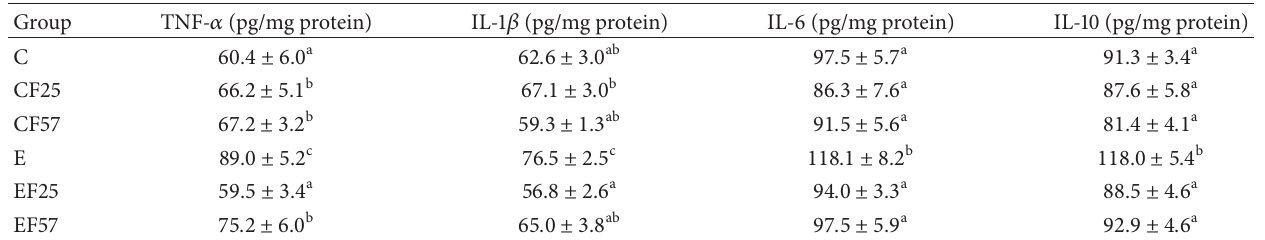
Table 6: Effects of fish oil on hepatic tumor necrosis factor- (TNF-) 𝛼 , interleukin- (IL-) 1 𝛽 , IL-6, and IL-10 levels in rats under chronic ethanol feeding 1,2